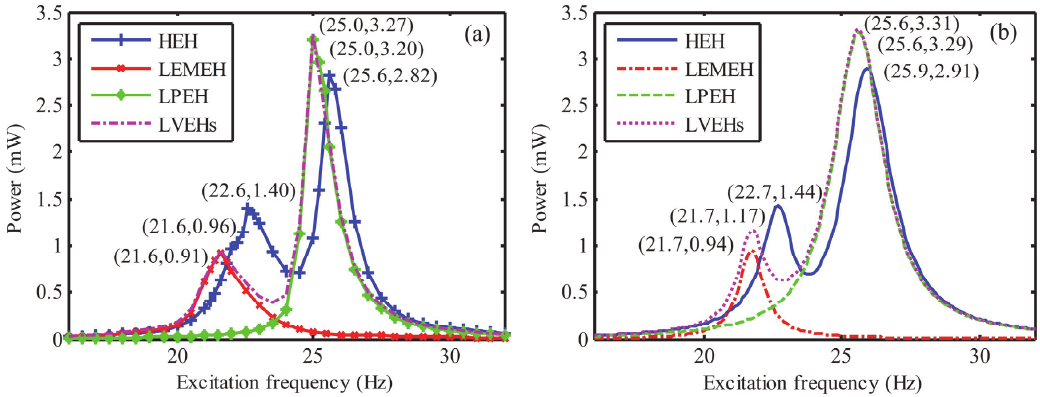
Figure 12. Frequency responses for the HEH, LEMEH, LPEH and LVEHs: ( a ) experimental results; ( b ) numerical results.